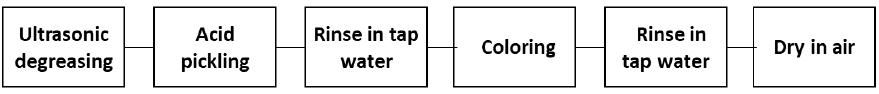
Figure 1. Stereomicroscope image of untreated aluminum surface.